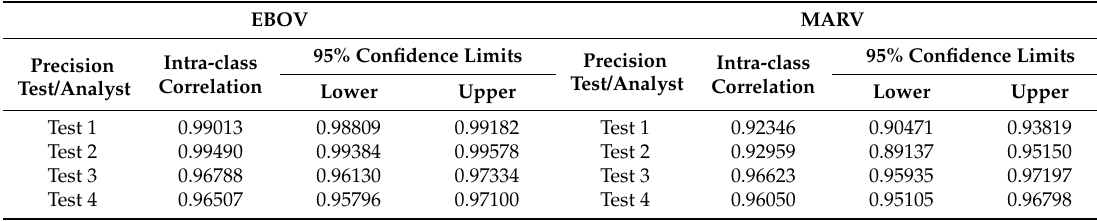
Figure 2. Bland–Altman analysis demonstrates a visual representation of the agreement between plaque numbers counted by two individual analysts. Table 5. Intra ‐ Class Correlation (ICC) analysis reveals a high level of agreement in plaque counts between two analysts collecting data using the same methods.